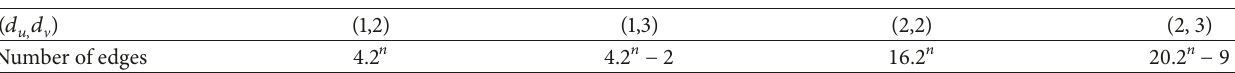
Table 4: Edge partition of Poly(EThyleneAmidoAmine dendrimers based on degree of end vertices of each